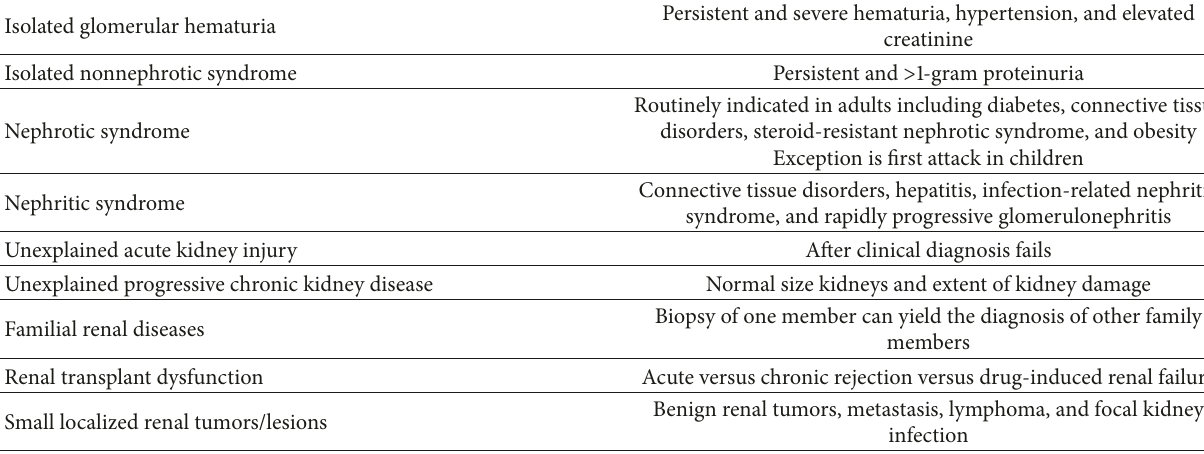
Table 2: Renal biopsy